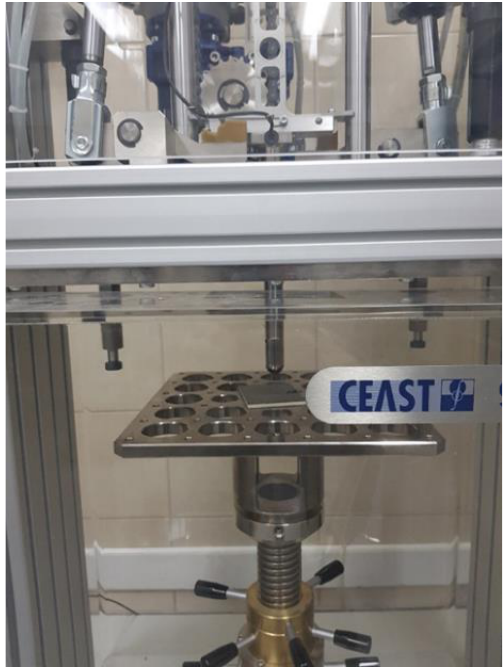
Figure 4. Sample on the table after a conducted test. Three samples of each type of a composite were tested, using the abovementioned parameters. As damage indicators, the depth of the indentation caused by the impactor loading the sample was measured (Figure 5). The depth was determined by means of a depth micrometer.